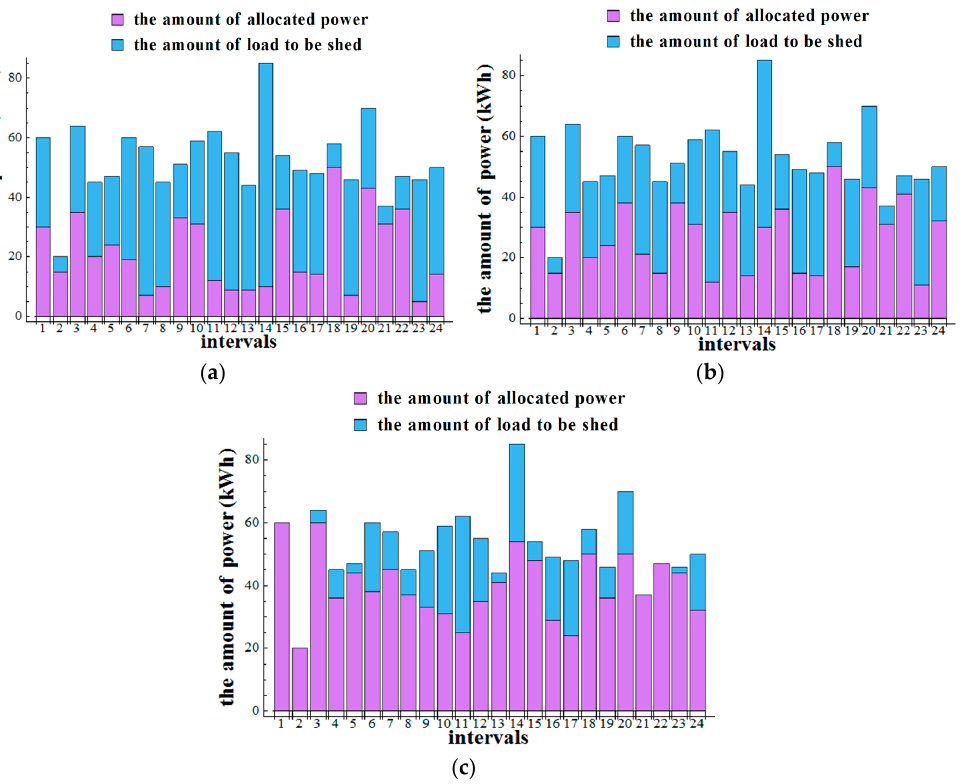
Figure 4. Number of shed demands of a specific Ag load in three test scenarios. ( a ) When the 50% test scenario is used; ( b ) when the 65% test scenario is used; and ( c ) when the 80% test scenario is used.